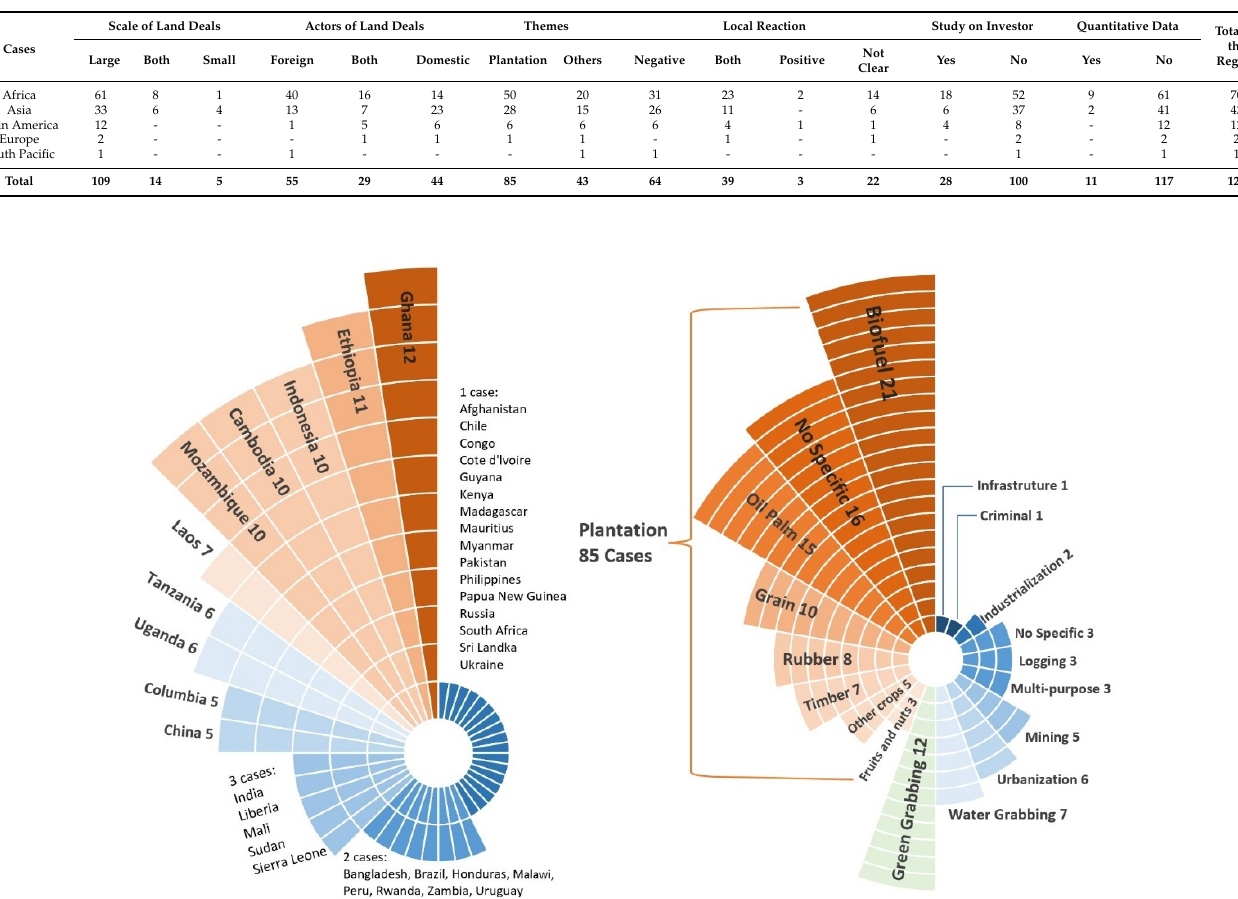
Figure 2. Case locations by country and grabbing types ( n = 128).